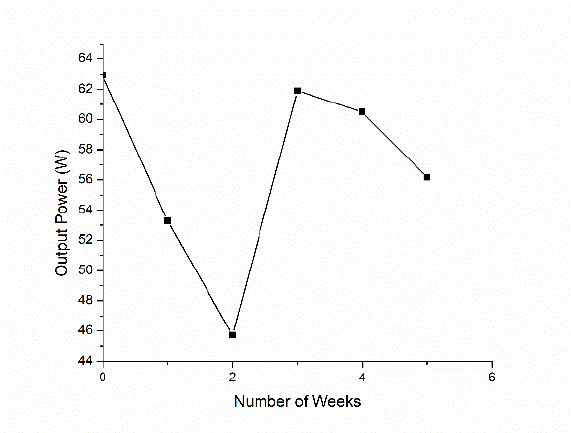
Figure 15. Output power measured weekly without cleaning. Table 6. Dust reduction for all patterns.